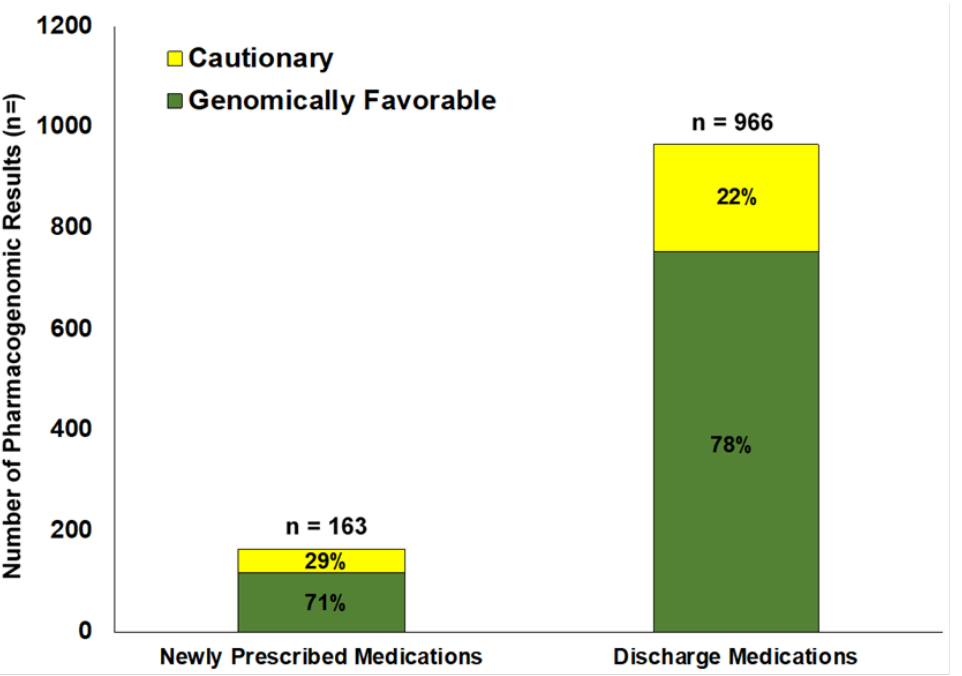
Figure 1. Pharmacogenomic results available during hospitalizations of African American patients by medication type and genomic risk level. Results are shown for n = 135 African American patients with readmissions to the hospital from 12 July 2017 to 18 June 2020. Pharmacogenomic results available via the GPS at the point-of-care included test results that were genomically favorable (green light; compatible), cautionary (yellow light; potentially increased genomic risk), and genomically unfavor- able (red light; genomic contraindication). Only two high-risk pharmacogenomic results (red lights) were observed during the study period (both as discharge medications); these are not displayed in Figure 1 as they constituted <1% of all results. Pharmacogenomic results were accompanied